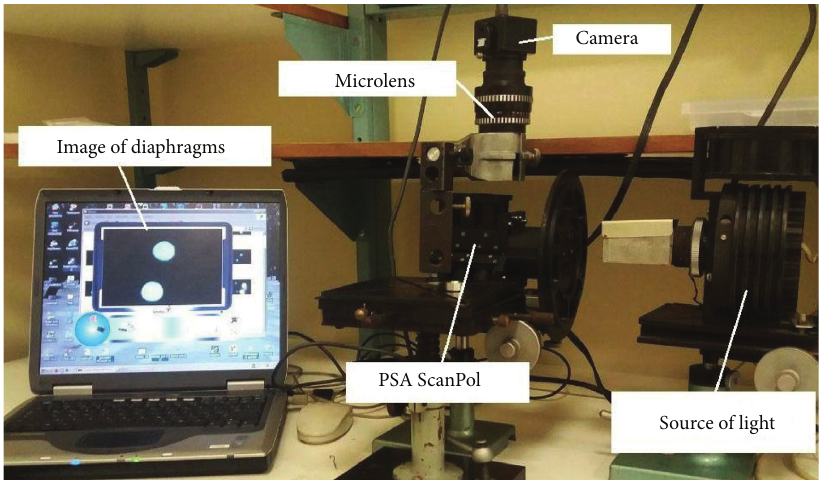
Figure 15: Bench for installation and alignment of PSA unit detectors.